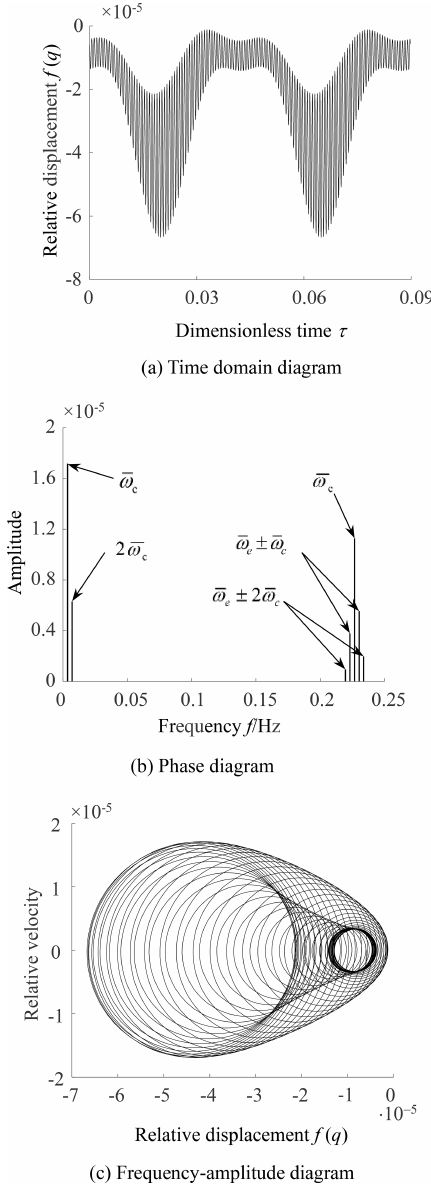
Figure 9. Dynamic response with ω 1 = 140rad per second.